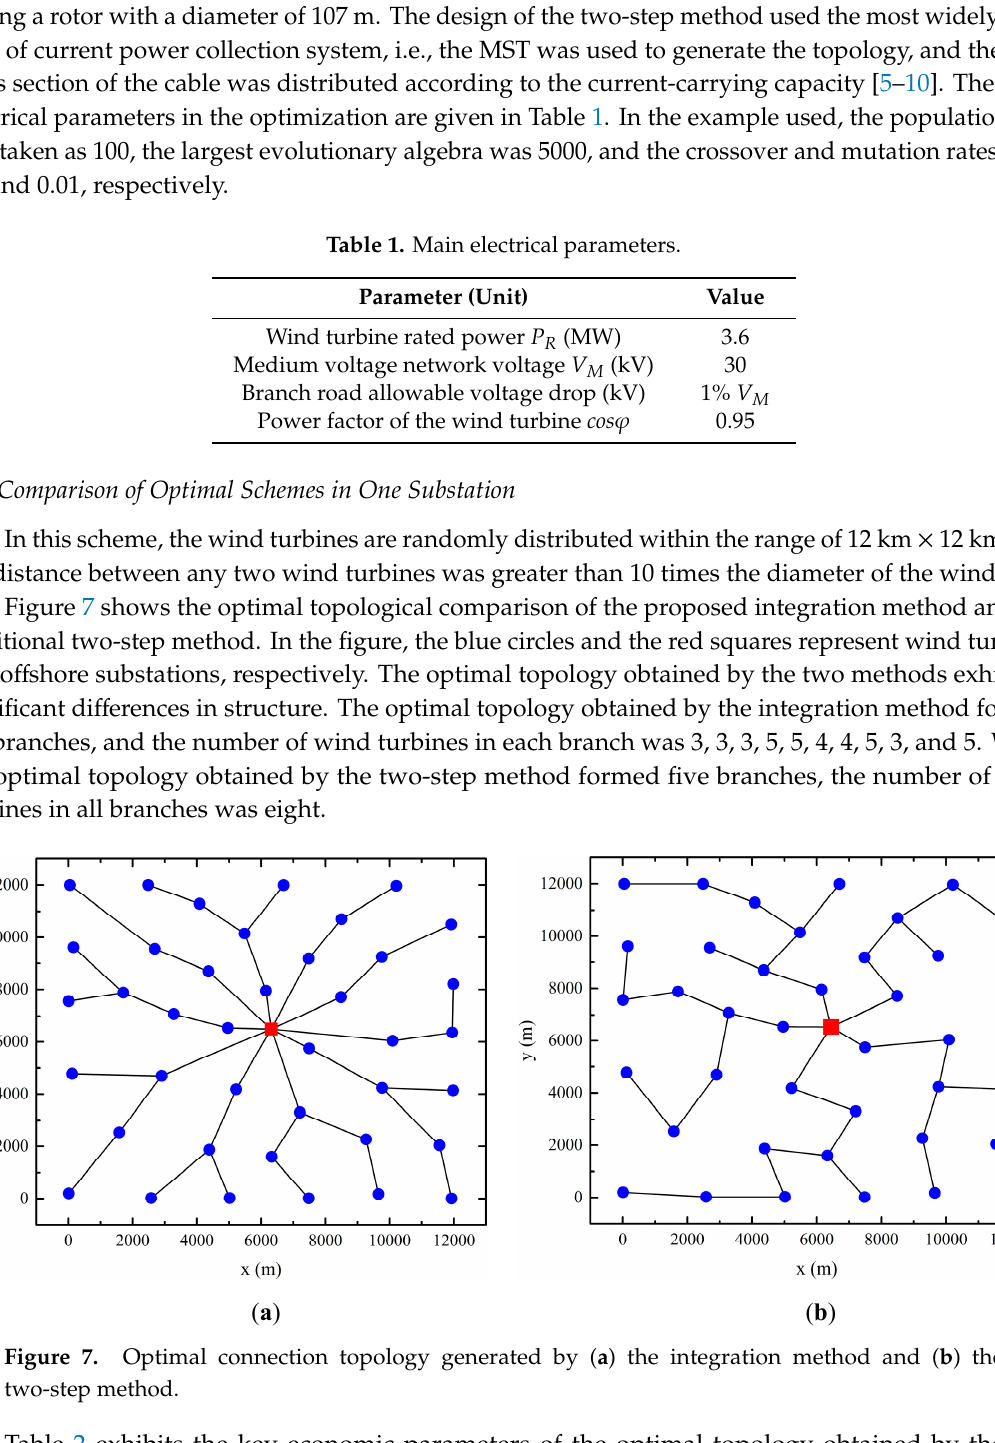
Figure 8. Comparison of the lengths of different cross-sectional cables used in the topology. Table 2. Comparison of key economic parameters of the topology (references for the % are the values obtained by the two-step method). Type